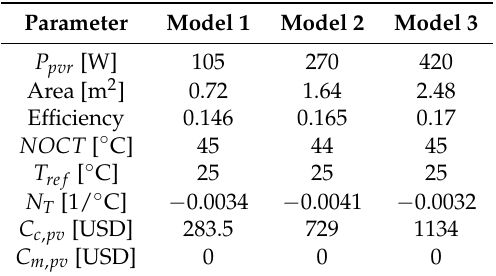
Table 4. Technical specifications of photo-voltaic panels [45–47].